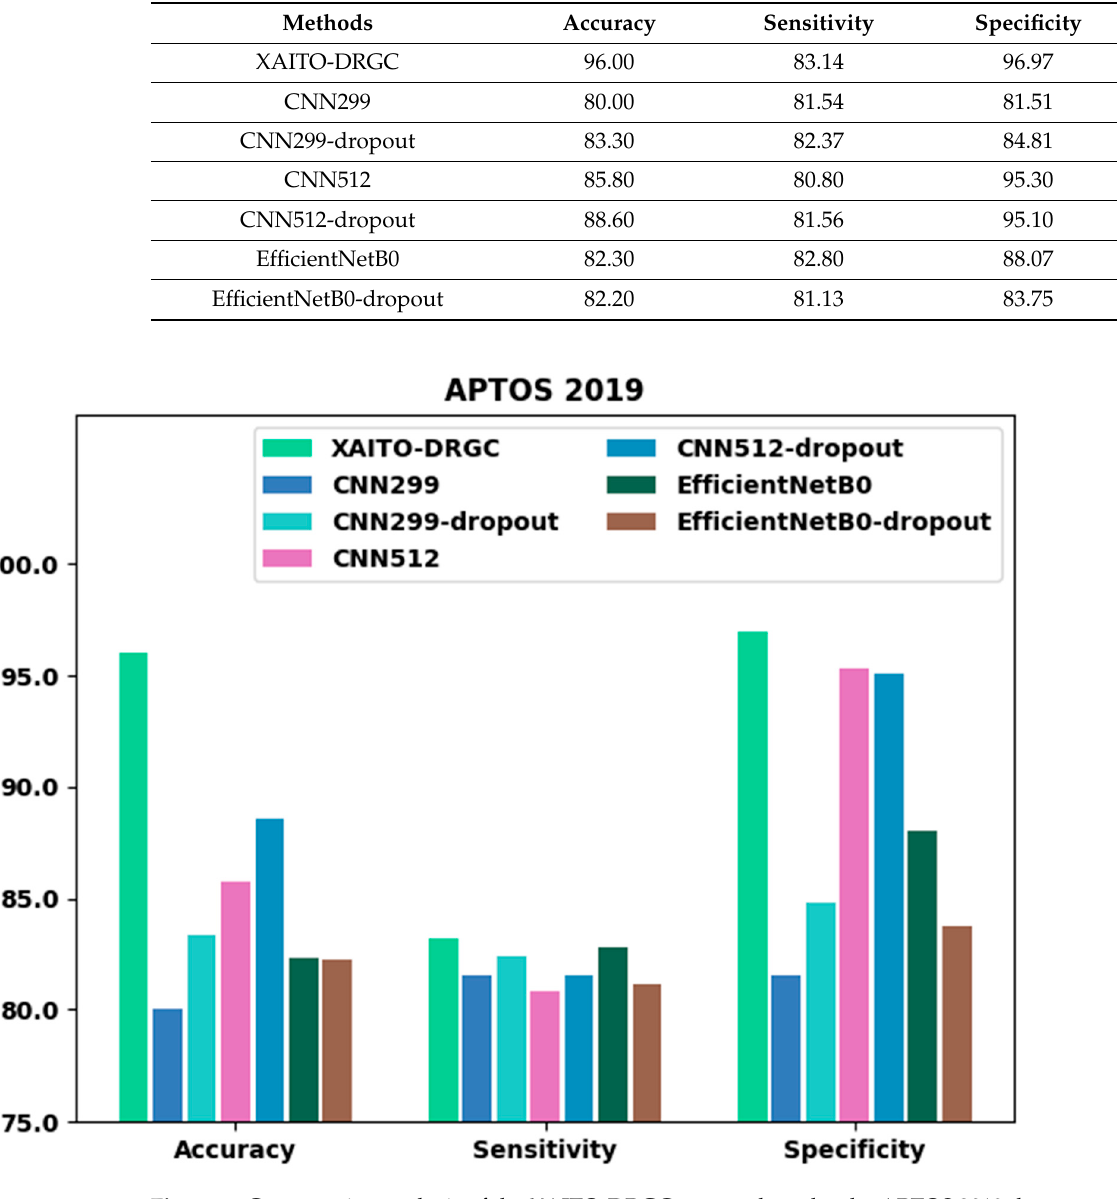
Figure 7. Comparative analysis of the XAITO-DRGC approach under the APTOS 2019 dataset. Figure 8 signifies the confusion matrices given by the XAITO-DRGC method on the DDR dataset. On the entire dataset, the XAITO-DRGC algorithm has identified 1225 sam- ples as normal, 105 samples as mild, 867 samples as moderate, 31 samples as severe, and 159 samples as proliferative. Furthermore, on 70% of TR data, the XAITO-DRGC